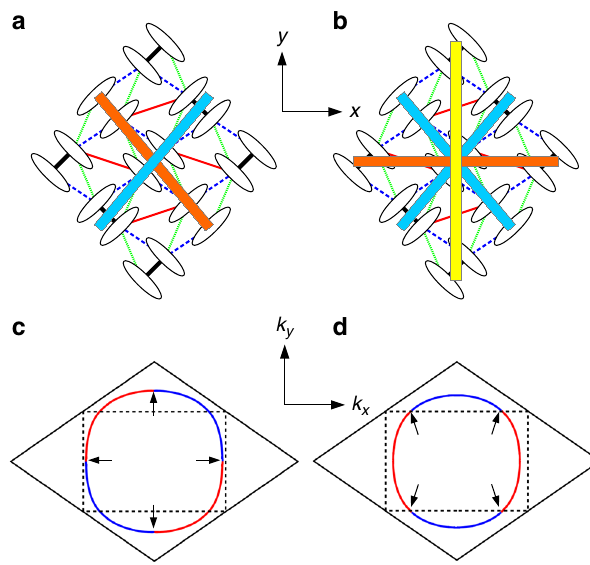
Fig. 4 Symmetry of superconducting gap functions. Schematic real space pairing of the d xy -wave ( a ) and the extended- s + d x 2 -wave ( b ), and sign (cid:1) y 2 changes of the gap function on the FS for the d xy -wave ( c ) and the extended- s + d x 2 -wave ( d ). Red (blue) in c and d represents plus (cid:1) y 2 (minus) sign of the gap function and arrows indicate node points on the FS. The dotted rectangle is the original fi rst Brillouin zone and the solid rhombus is the unfolded Brillouin zone when the dimer model is